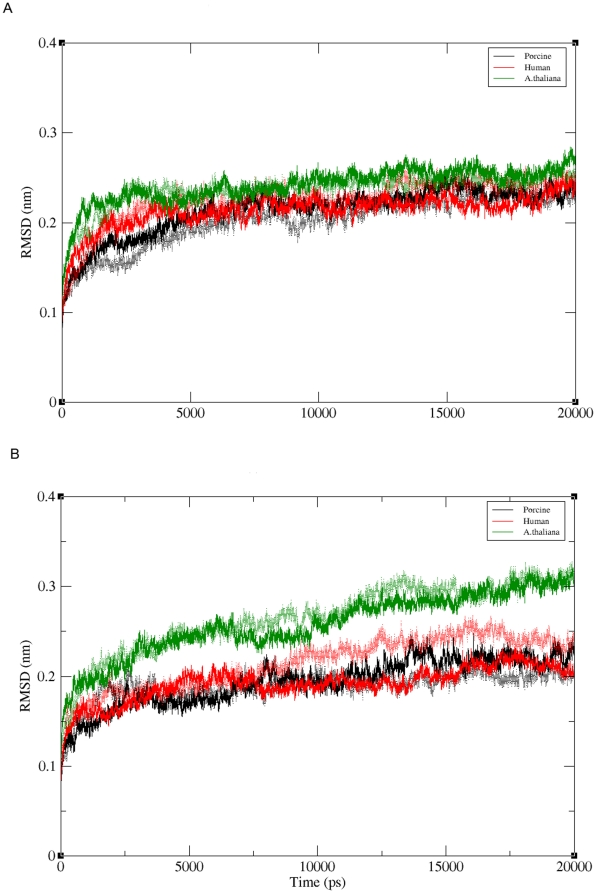
Root mean square deviations (rmsd) of backbone Cα of three POP species during simulation.
a) rmsd of bound form of porcine (black), human (red) and A. thaliana (green) POPs b) rmsd of unbound form of porcine, human and A. thaliana POPs. Dotted line indicates rmsd of replicate runs.